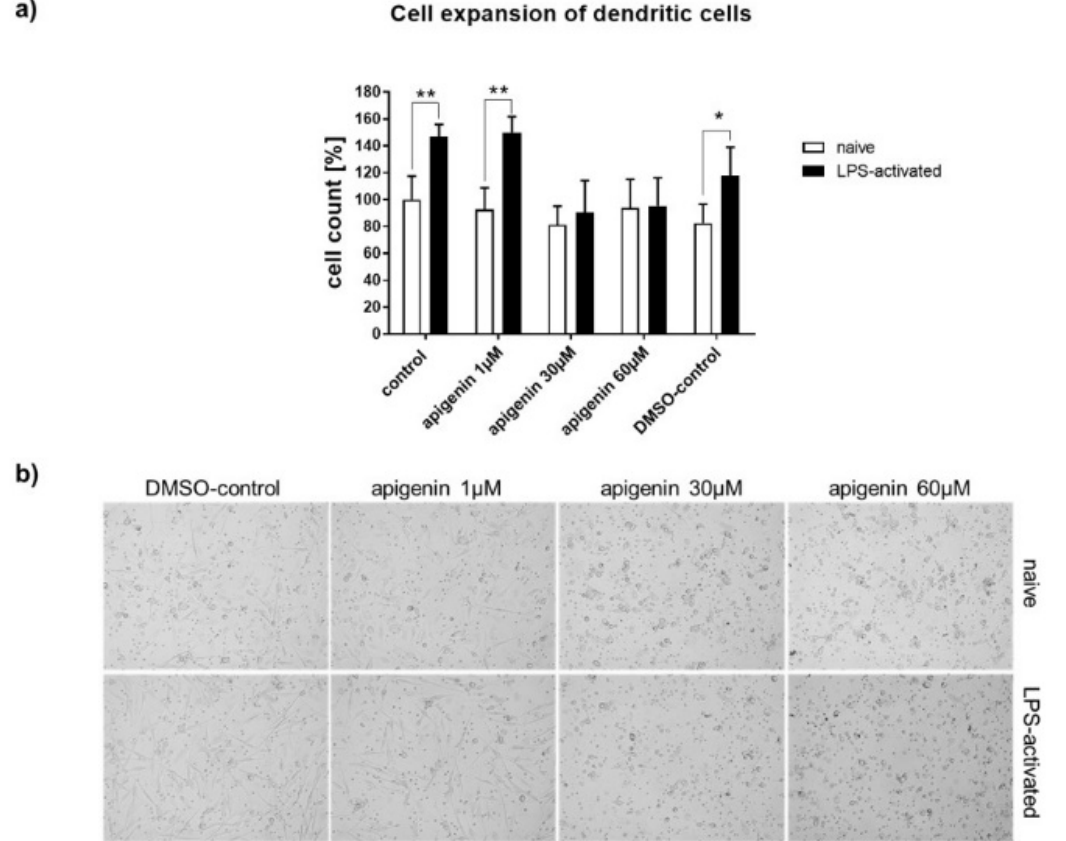
Figure 8. ( a ) Cell expansion of human dendritic cells after 24h with vehicle, Api in different concentrations or DMSO in the absence (native) or presence of LPS. ( b ) Representative transmitted light microscopic images of Api stimulated human dendritic cells after 24 h in the absence (native) or presence of LPS (magnification 20 × ). * p < 0.05; ** p < 0.01.